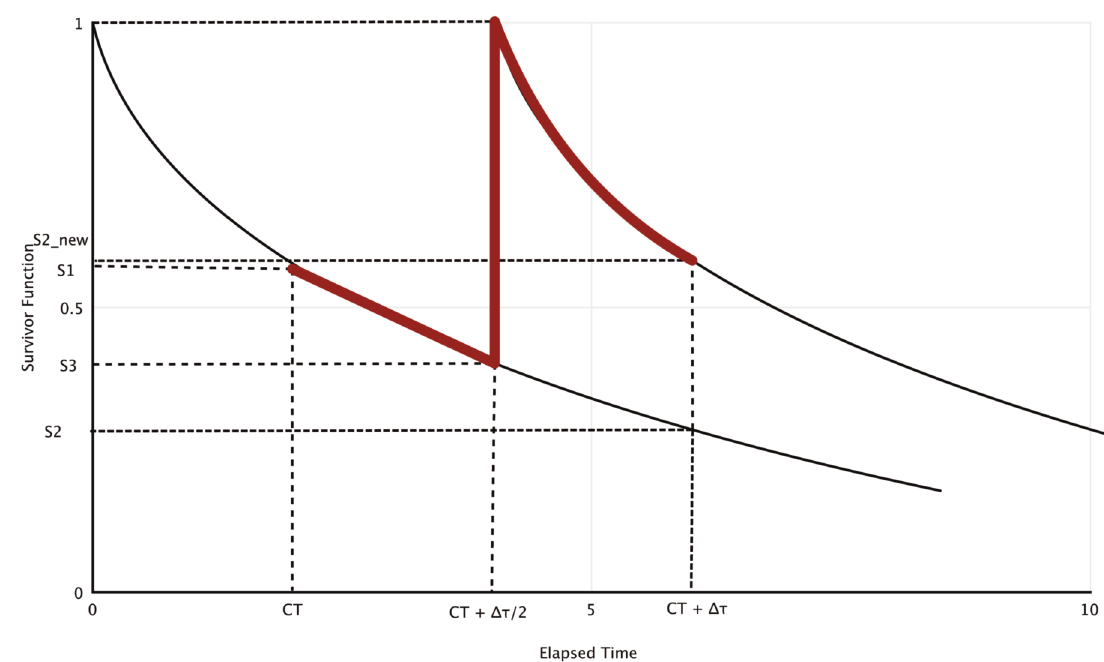
Figure 5. Schematization of Equation (7). The red line shows the probability that accounts for the effects of the seismicity that occurred before Dx and its increase due to the occurrence of an event at CT+ Dx /2.